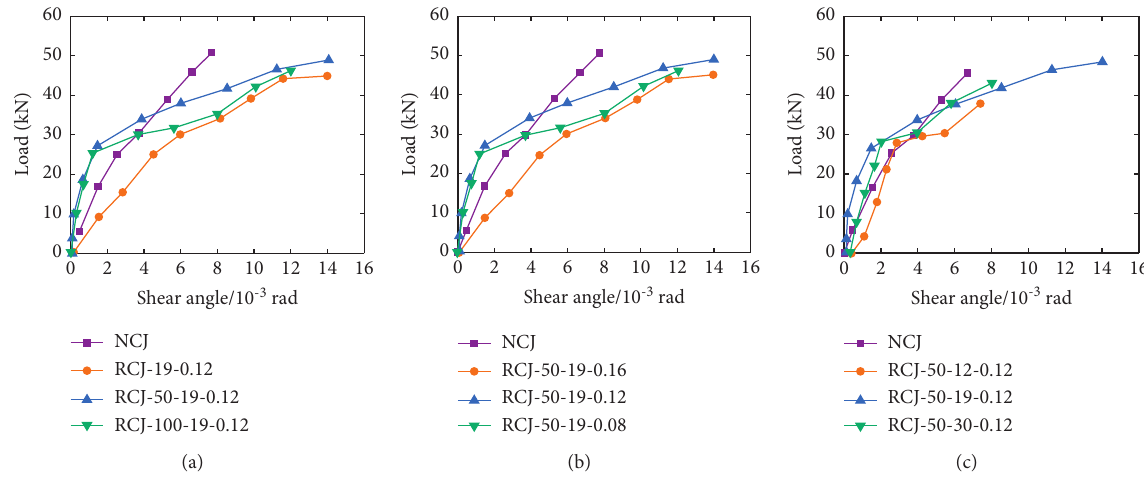
Figure 13: Shear deformation-load curve. (a) Replacement rate of RCA. (b) Volume of waste fibers. (c) Length of waste